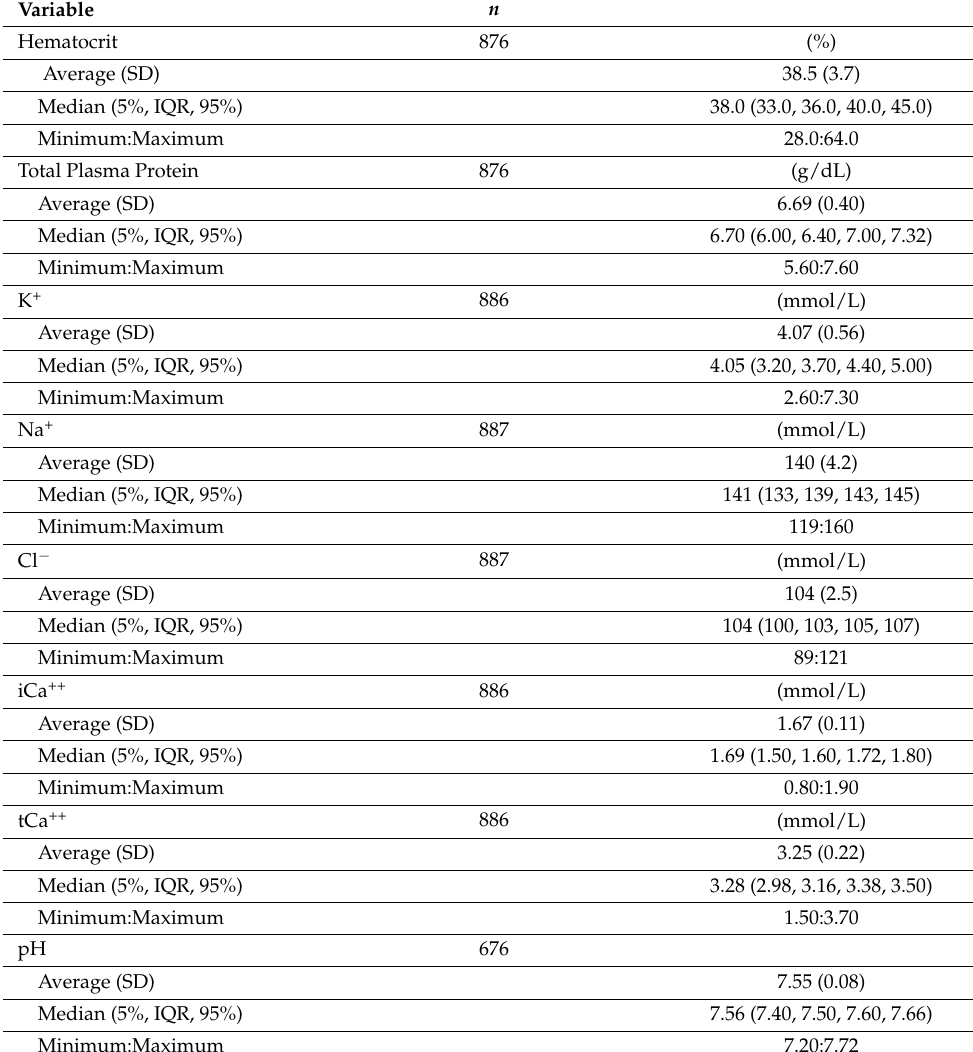
Table 2. Hydroelectrolyte, acid–base, and hematological values for horses